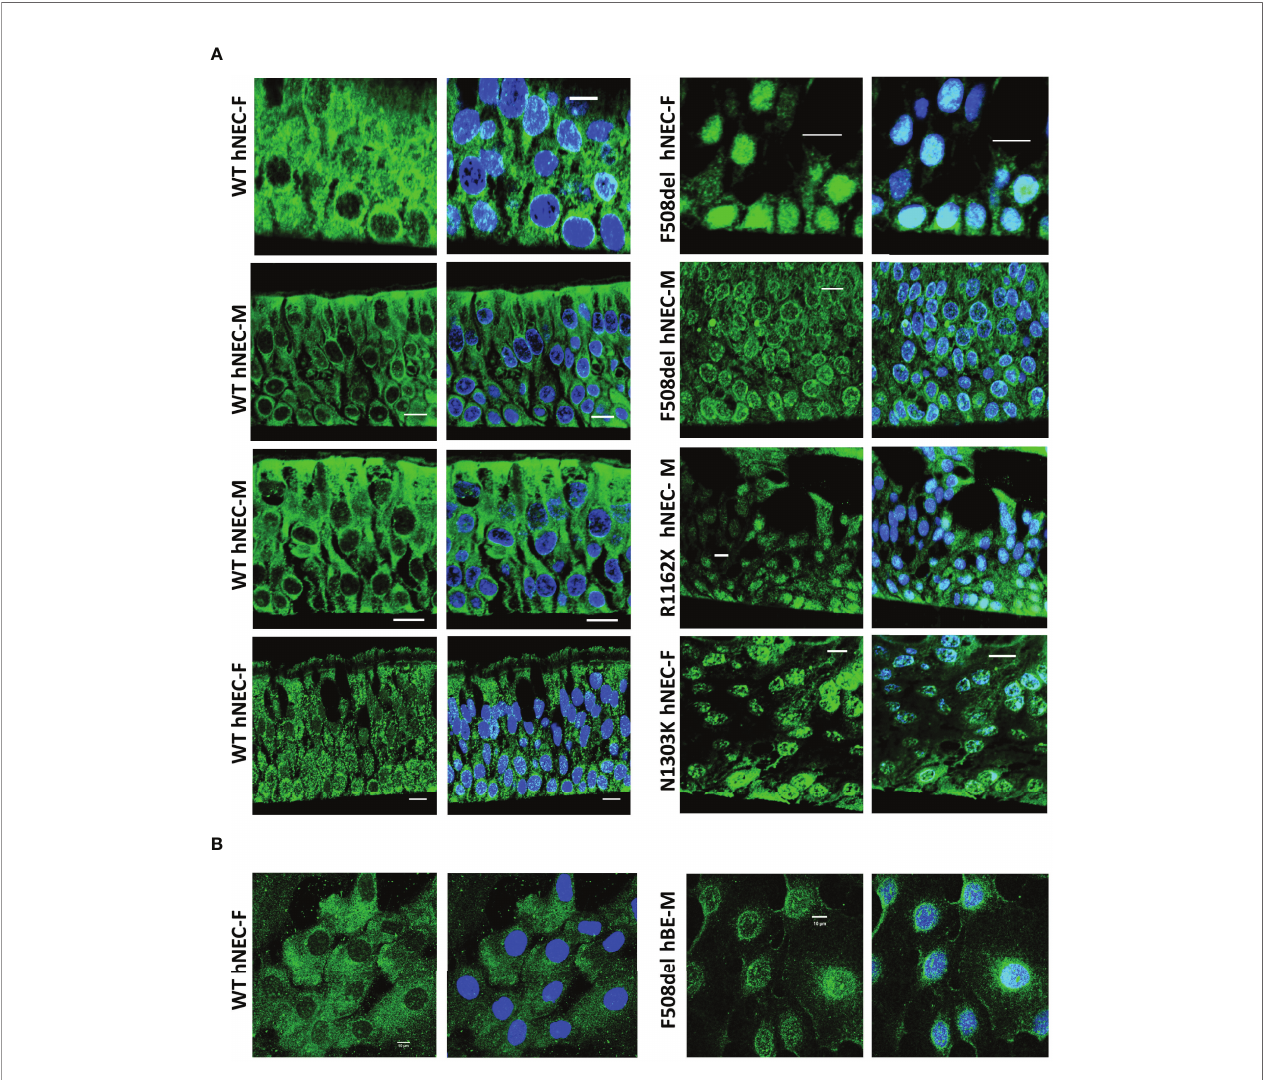
FIGURE 9 | 5-LO localization in hNEC. Typical 5-LO (green) immuno- fl uorescence confocal images of airway (nasal: hNEC and bronchial: hBE) epithelial cells primary cultures derived from 9 different subjects with different CFTR mutations. The non-CF (WT, left) and CF (right) female (F) and male (M) airway primary cultures were (A) grown at ALI on permeable fi lters, embedded in paraf fi n and sliced or (B) grown on glass coverslips. Nucleus were stained in DAPI (blue).